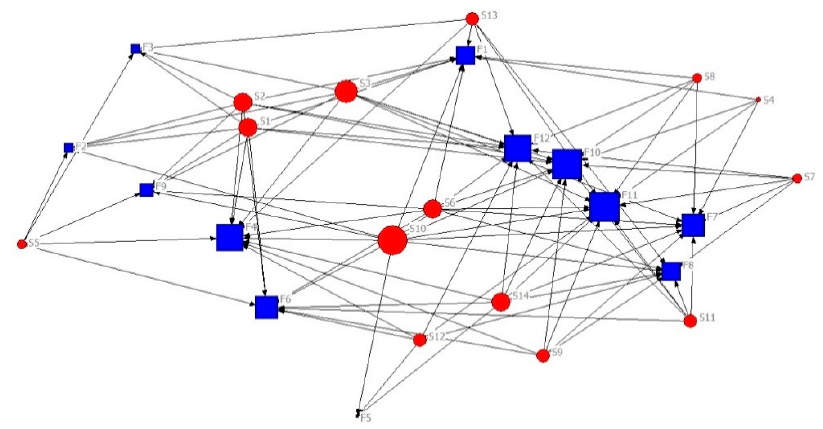
Figure 1. Visualization of the stakeholder–barrier network.